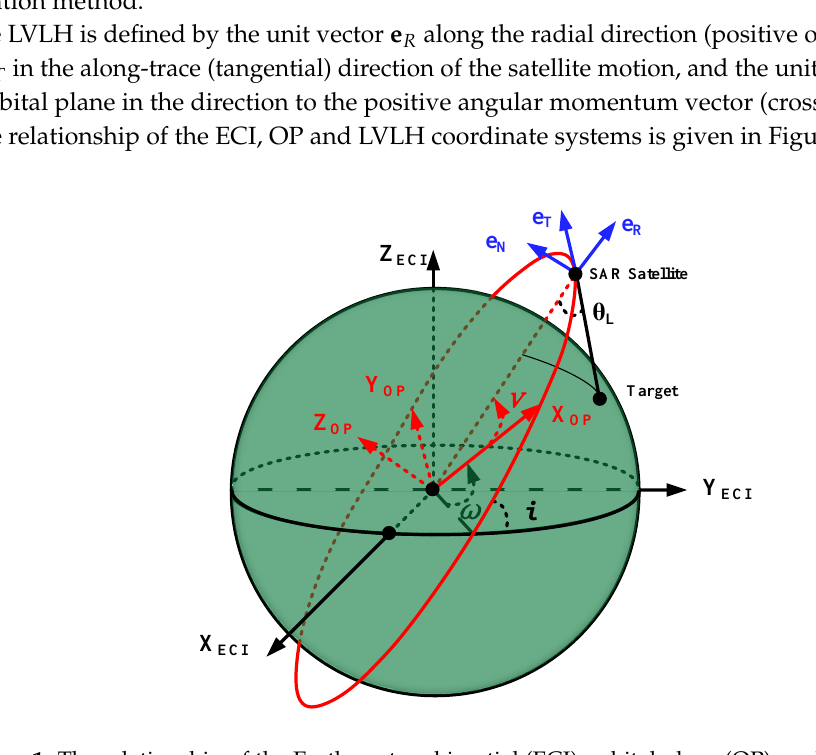
Figure 1. The relationship of the Earth centered inertial (ECI), orbital plane (OP), and local vertical, local horizontal (LVLH) coordinate systems. Elements related to the ECI, OP, and LVLH are colored in black, red, and blue, respectively, for clarity. The angle θ L from the SAR satellite is the center off-nadir angle within the antenna beam center to the nadir